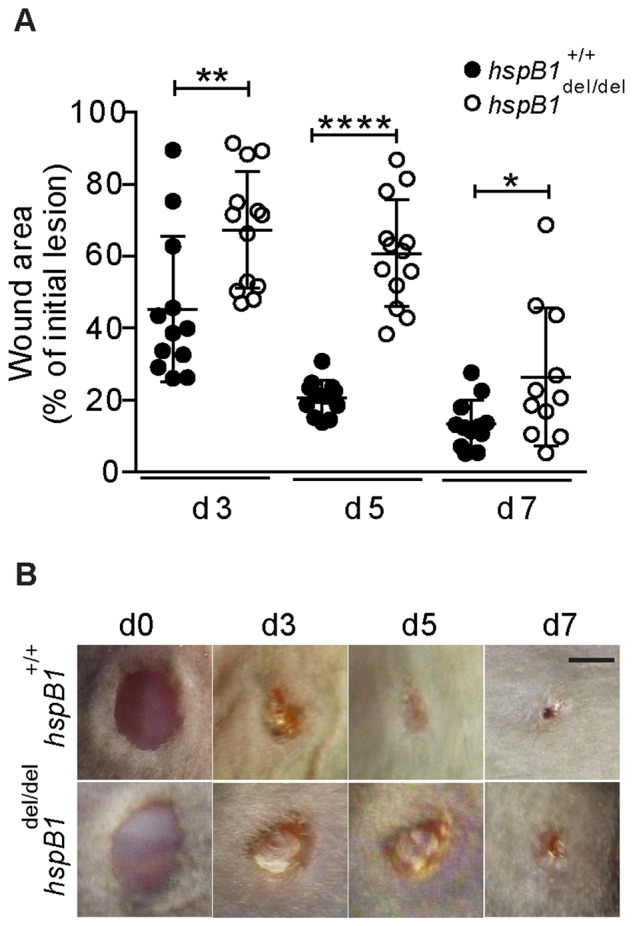
HspB1 deficiency impairs excisional cutaneous wound healing.A, Four 4–14 week-old female wild-type and hspB1
del/del mouse. Digital images were taken of each wound at d0, d3, d5 and d7 post-wounding (n = 3–4 mice). Individual wound areas were tracked over time and plotted as a percentage of the intial individual lesion areas±SD (*P<0.05, **P<0.01, ****P<0.0001). B, Digital images of wounds (representative of ≥14 wounds); bar = 2 mm.